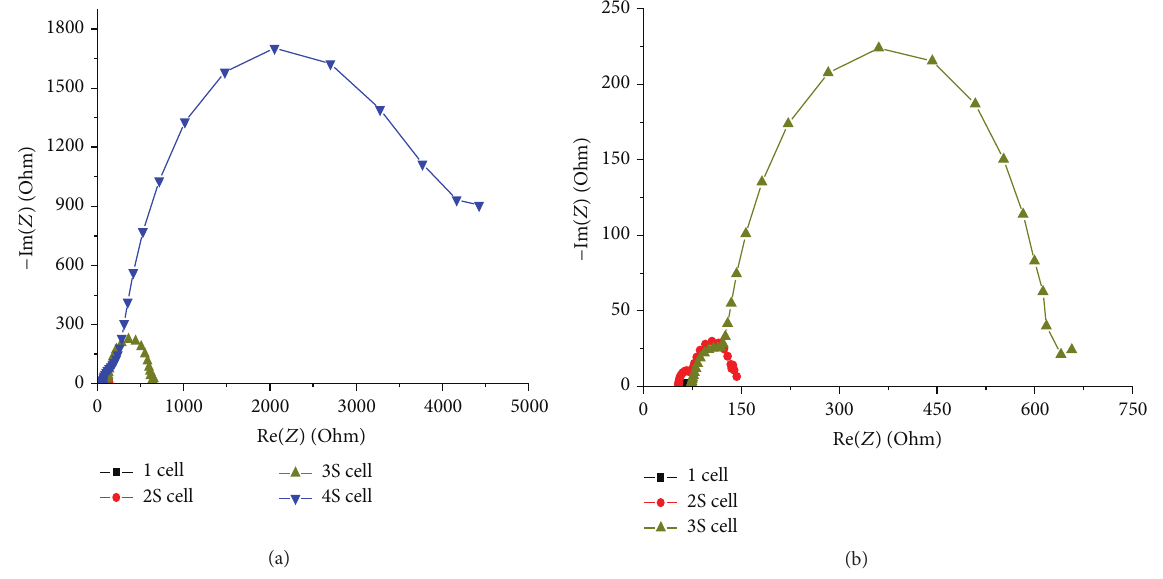
Figure 5: (a) Cells connected module assembly in series connection; (b) an enlarged